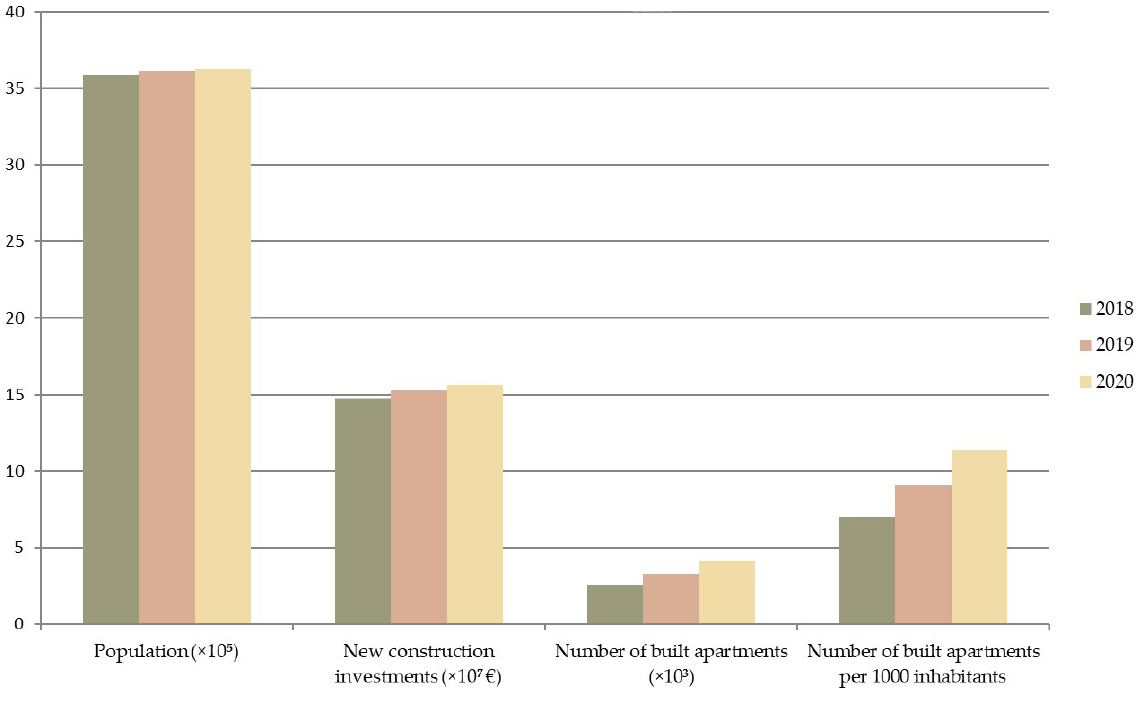
Figure 1. Indicators of urban population growth and urbanization intensification in the City of Novi Sad in 2018–2020 [27].